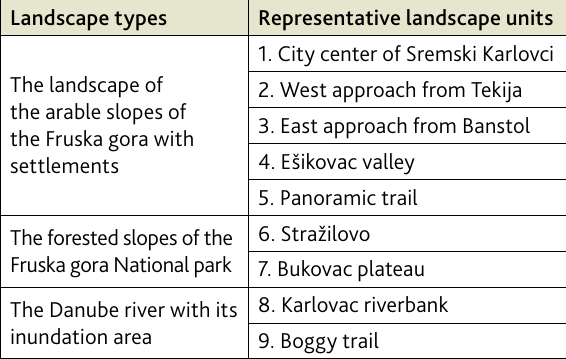
Table 1. Landscape types and representative landscape units Landscape